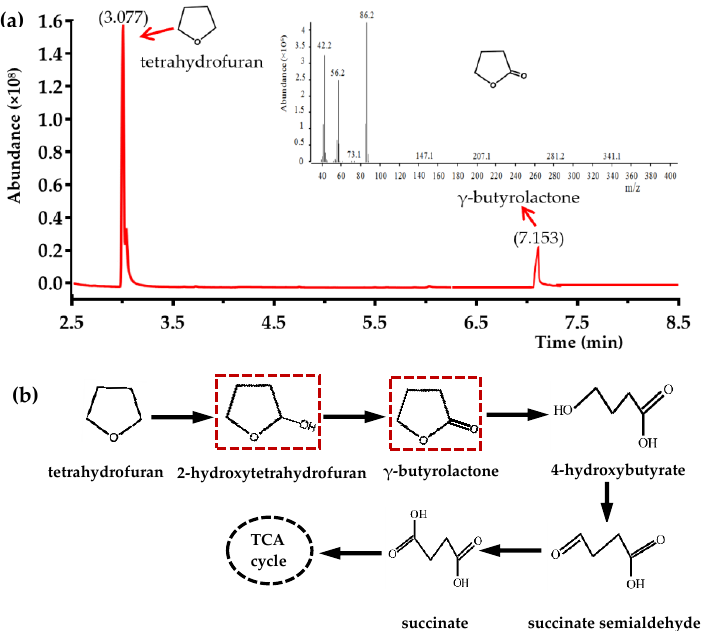
Figure 6. The identification of metabolites by GC-MS analyses and the proposed oxidation pathway of THF degradation by strain ZM01: ( a ) The MS spectrum of the produced metabolite γ-butyrolactone and ( b ) the presented pathway is based on the pathway originally suggested by Kristin, but the key metabolite 2-hydroxytetrahydrofuran was previously not been detected. The metabolites in the red dotted outline were detected during the THF degradation by strain ZM01. The actual formation of 2- hydroxytetrahydrofuran has been verified for the first time.